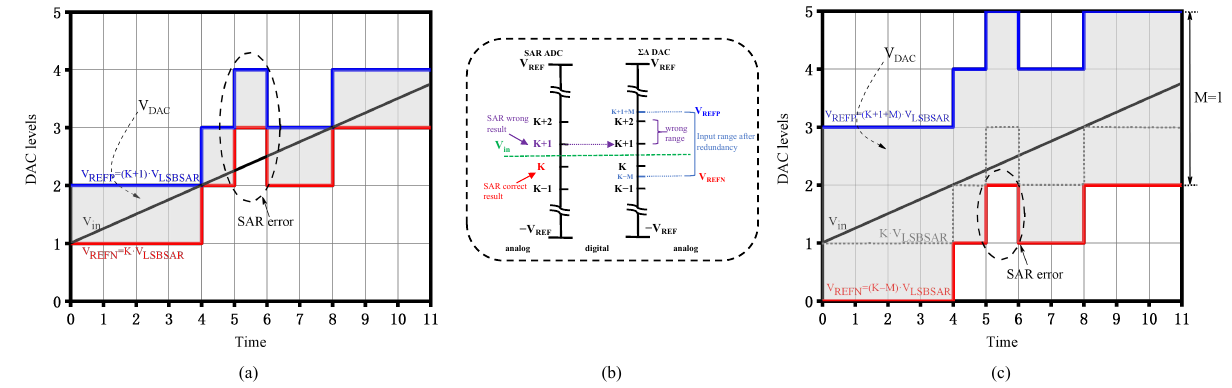
Figure 2. ( a ) Time domain waveform with coarse conversion error causing the input signal to be outside the reference range; ( b ) The coarse conversion result of the SAR ADC corresponds to the reference voltage range of the ∆Σ ADC; ( c ) Time domain waveform with input signal included in the reference range after